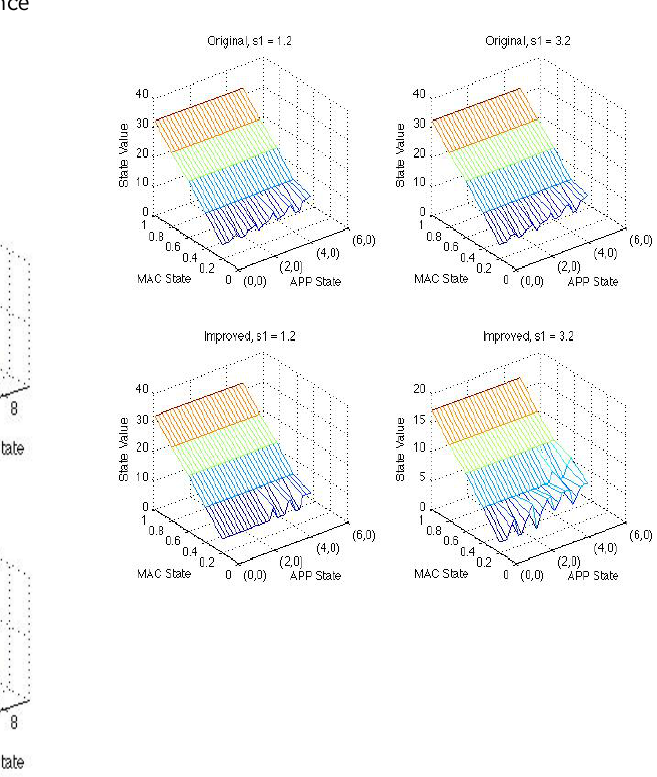
Figure 5a. Simulated state value of cost efficient application for cellular network.